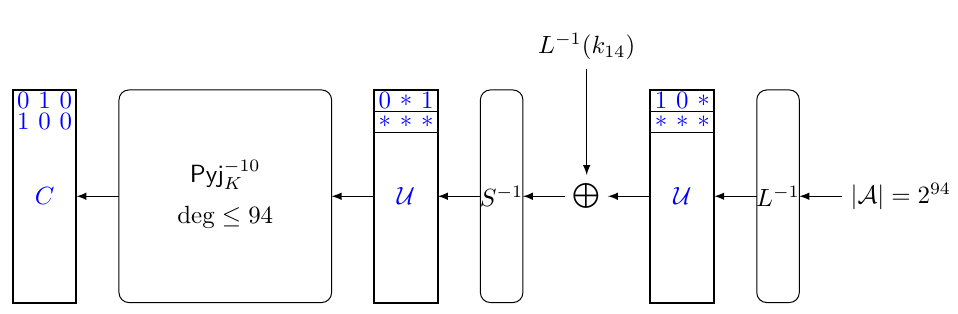
Figure 4: Integral distinguisher on 11 . 5 rounds of the decryption of Pyjamask-96 , for v 0 = 100 (as defined in Section 4) and L − 1 ( k 14 ) = 10 ∗ ∗ · · ·